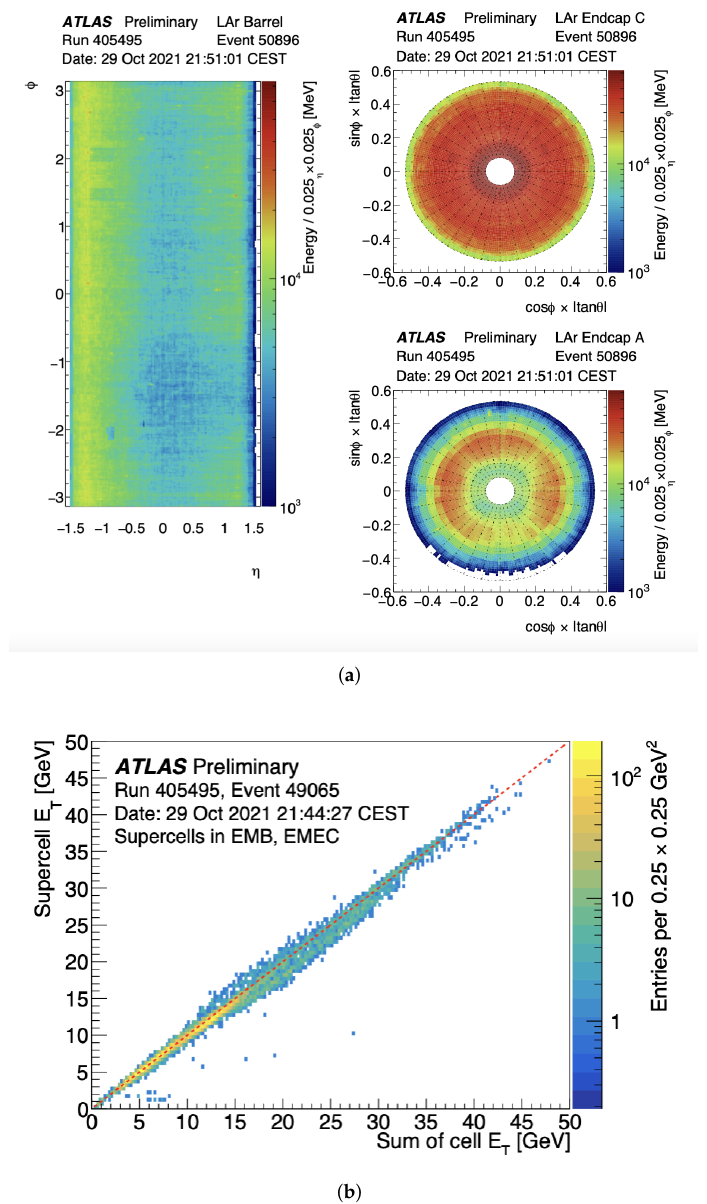
Figure 10. LAr cell energy sums distributed in a hypothetical tower grid with ∆ η × ∆Φ = 0.025 × 0.025 in the endcap C, in the barrel and in the endcap A ( a ), and measured SC E T from all layers of the LAr Electromagnetic Barrel (EMB) and Electromagnetic Endcaps (EMEC), compared to the summed transverse energies from their constituent calorimeter cells, obtained through the main readout path ( b ) with data from a single event of a beam splash run in October